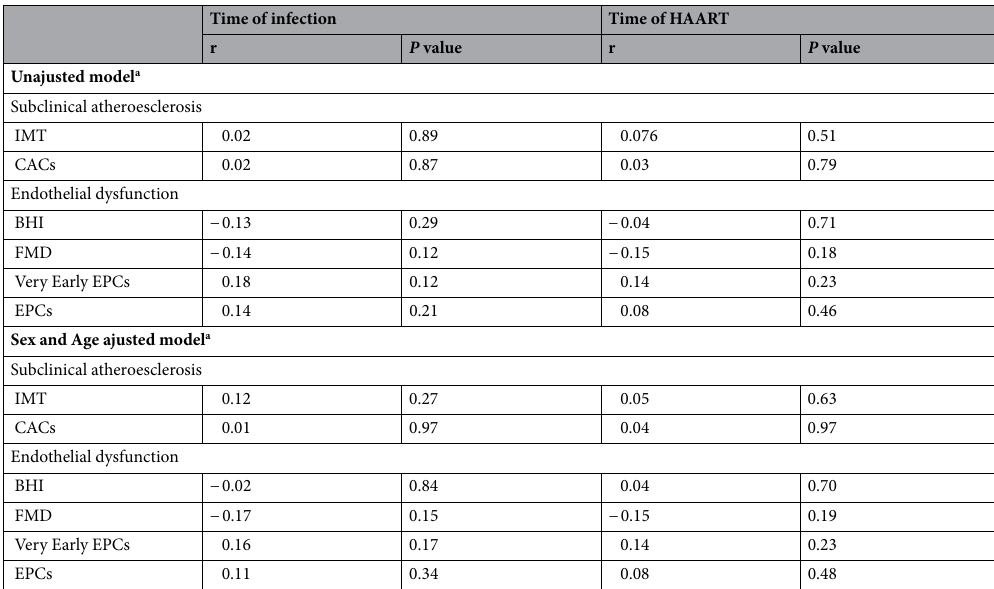
Table 6. Correlation between HIV-related analytical parameters and subclinical atherosclerosis and endothelial dysfunction. Unadjusted model and sex- and age-adjusted model. HAART high active antiretroviral activity, IMT intima media thickness, CACs coronary artery calcium score, BHI breath holding index, FMD flow mediated dilation, EPC endothelial progenitor cells. a Multiple linear regression models.